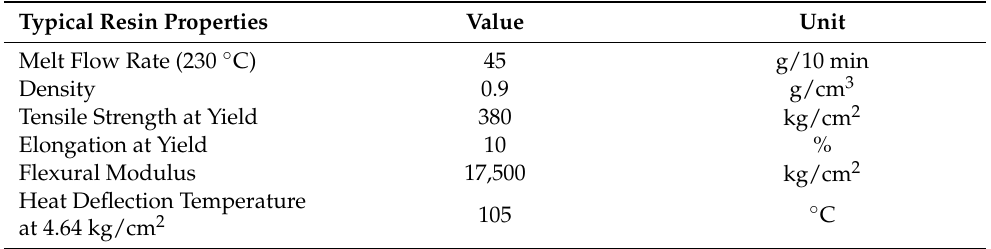
Table 2. The main characteristics of the polypropylene (Homopolymer G452) used in this